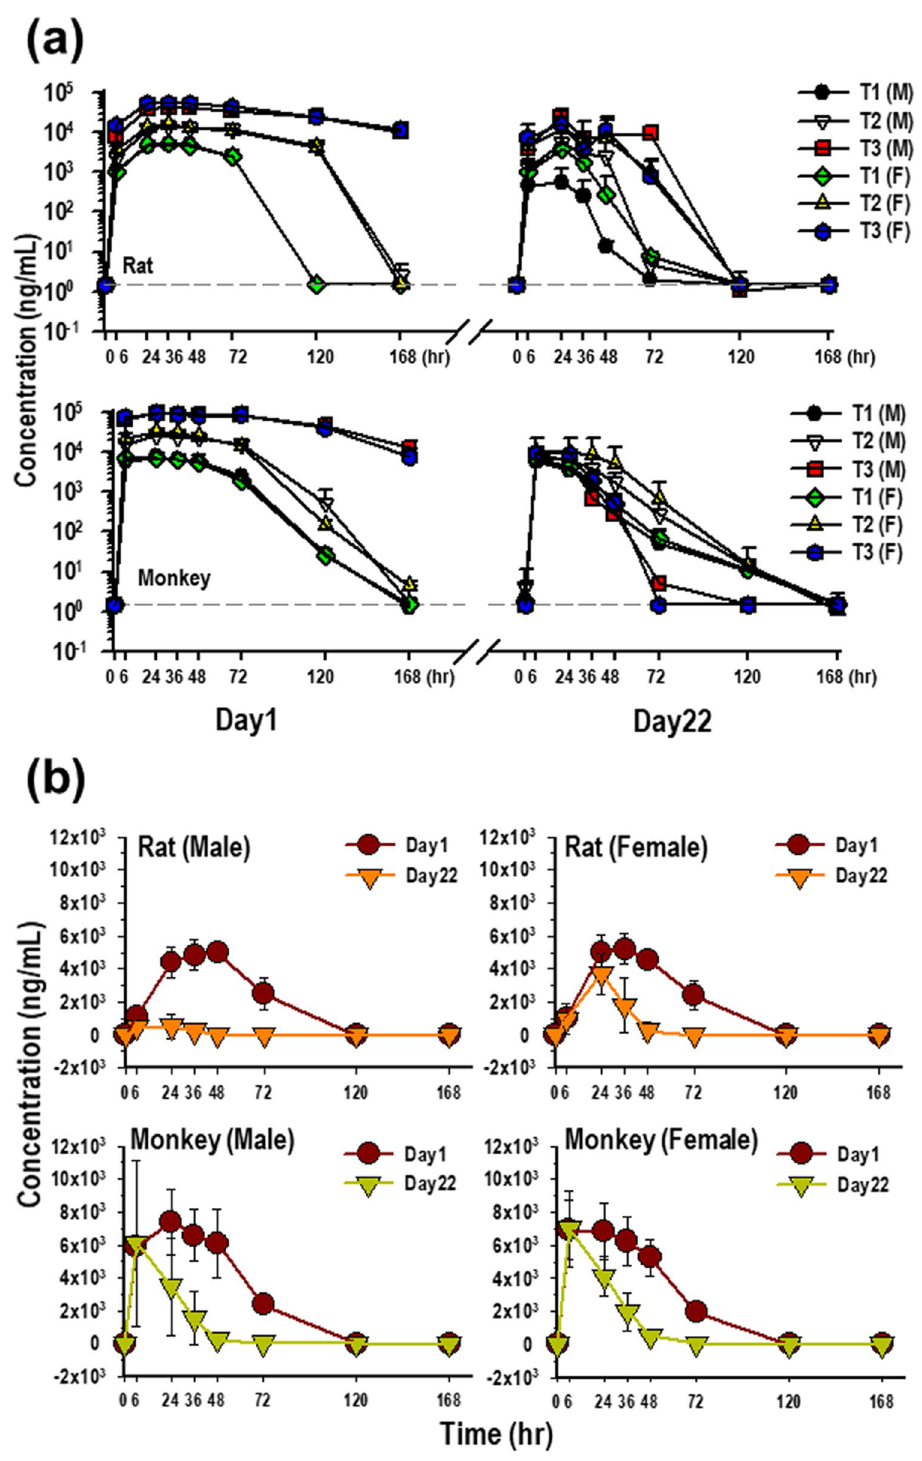
Figure 8. Evaluation of the impact of immunogenicity on GX-G3 toxicokinetic analysis, in rats and monkeys subjected to 4-week repeated subcutaneous injection with GX-G3 followed by a 4-week recovery period. Each species was separated into 4 injection subgroups: VC (vehicle control), T1 (1 mg/kg GX-G3), T2 (3 mg/ kg GX-G3), and T3 (10 mg/kg GX-G3). ( a ) Measurement of GX-G3 concentration–time profiles after subcutaneous administration of GX-G3 on Day 1 (Week 0) and Day 22 (Week 3) in rats and monkeys. ( b ) Representative concentration–time profile of T1 group on Day 1 and Day 22 in rats and